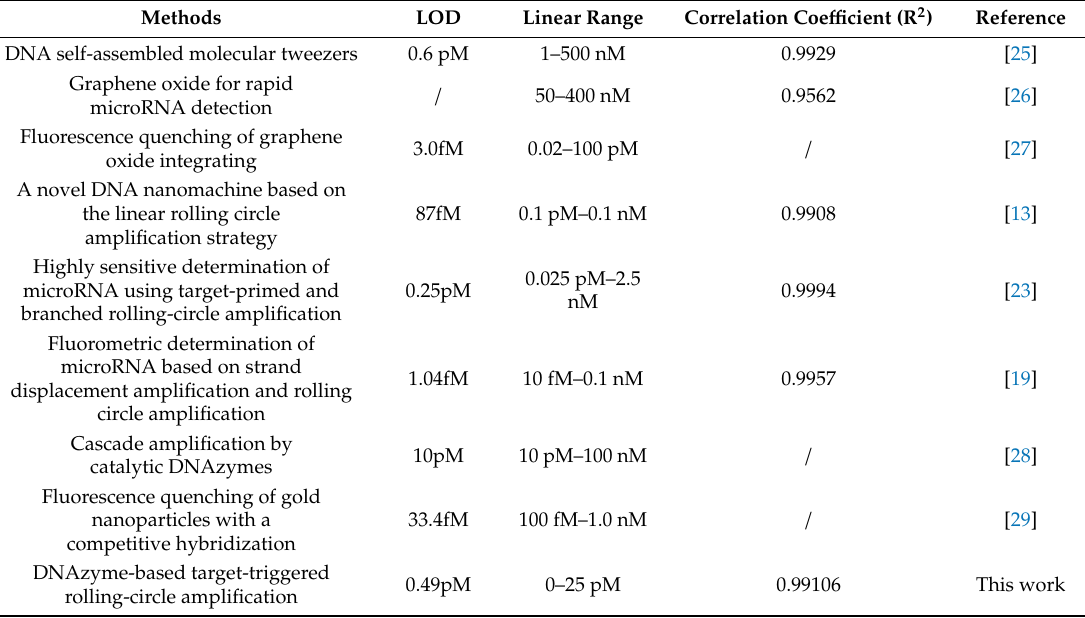
Figure 9. ( a ) Fluorescence spectra of miR-21 at different concentrations in serum. ( b ) The standard curve of miR-21. Table 2. Comparison of other methods for microRNAs